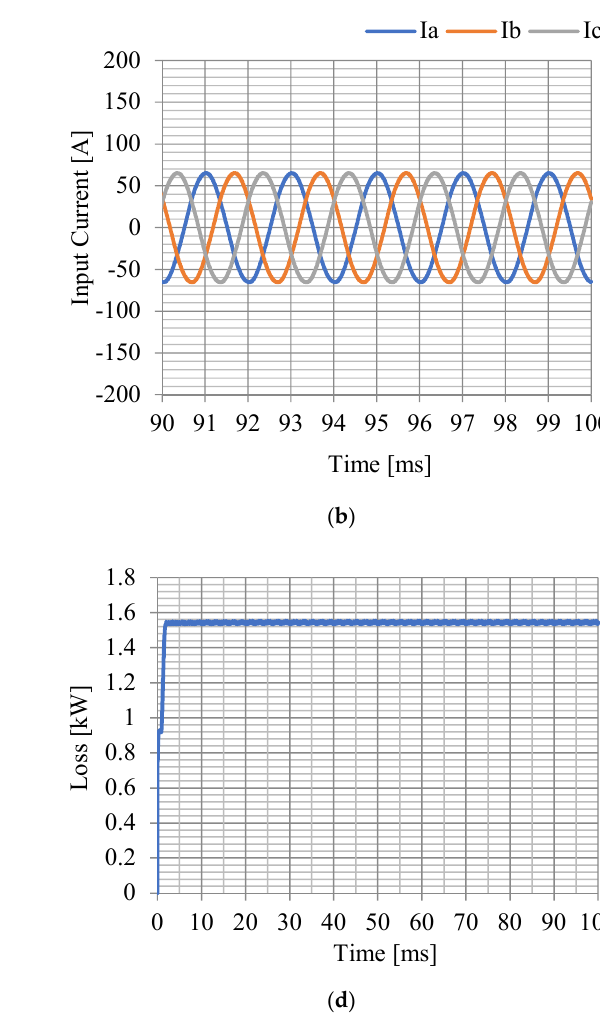
Figure 10. Characteristics at 30 krpm (30 kW electric driven mode): ( a ) Input voltage. ( b ) Input current. ( c ) Input power. ( d ) Loss.